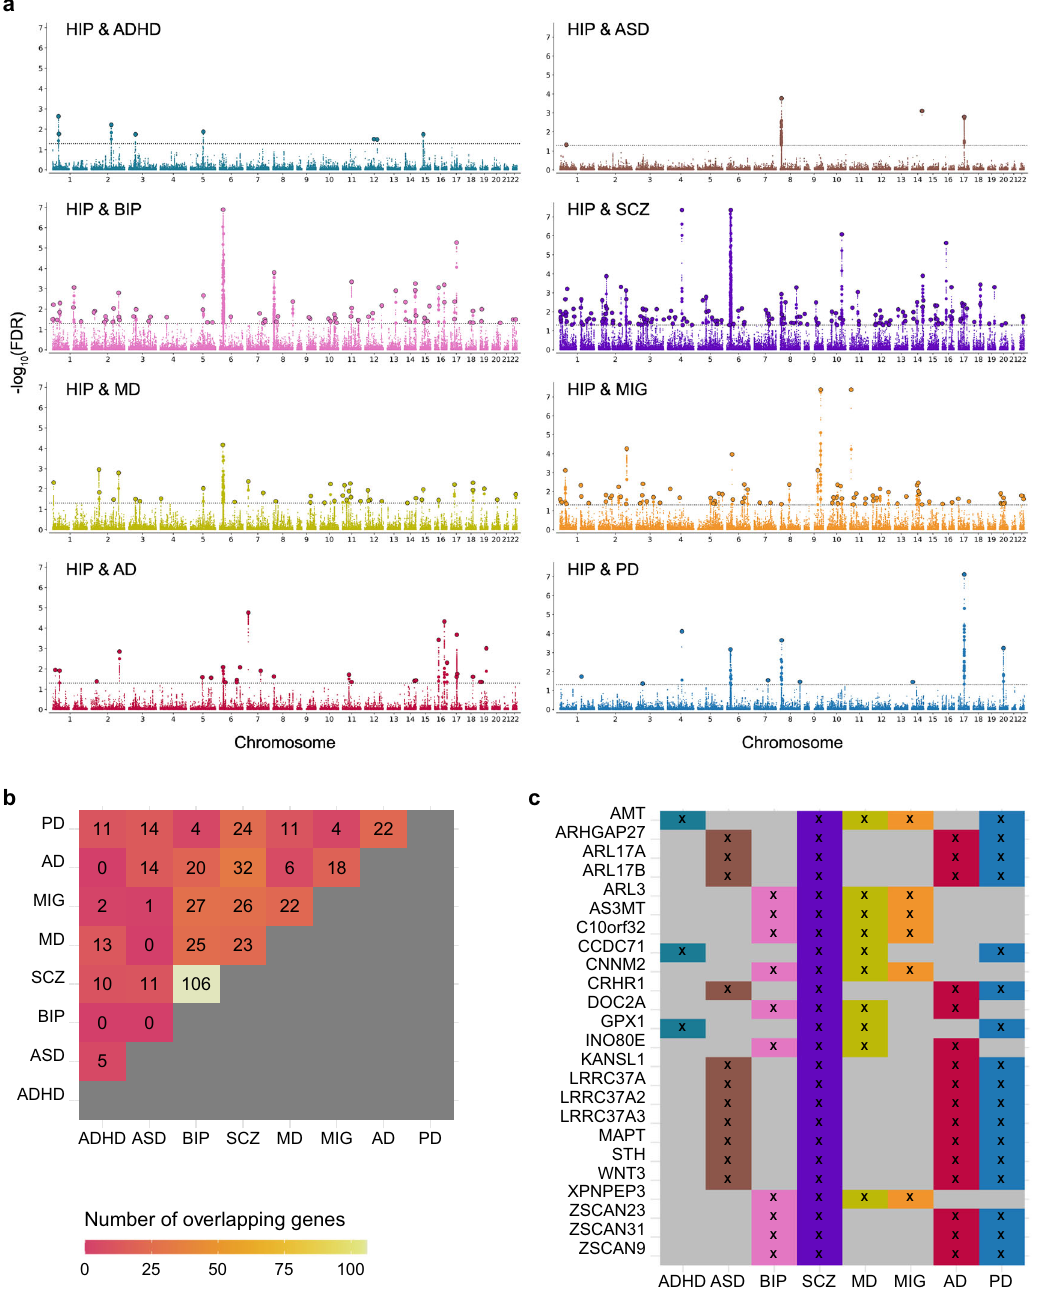
Fig. 3 Genetic overlap between hippocampal formation and eight disorders with different onset times across the lifespan. a For each disorder, a conjunctional FDR Manhattan plot is shown, illustrating the – log10 transformed conjunctional FDR values for each SNP on the y- axis and chromosomal positions along the x -axis. The dotted horizontal line represents the threshold for signi fi cant shared associations (conjFDR < 0.05). Independent lead SNPs are encircled in black. b Various genes mapped from the conjunctional FDR analysis were implied to overlap between hippocampal formation and multiple disorders. The fi gure illustrates the total number of genes implied in each combination of disorders. For example, 106 of the genes overlapping between hippocampal formation and SCZ were also found to overlap between hippocampal formation and BIP. c Panel c complements panel b with a list of genes that were implied for more than 3 disorders. One gene was mapped for fi ve disorders ( AMT ) and 23 genes were mapped for four disorders. ASD autism spectrum disorder, ADHD attention de fi cit hyperactivity disorder, SCZ schizophrenia, BIP bipolar disorder, MIG migraine, MD, major depression, PD Parkinson ’ s disease, AD Alzheimer ’ s disease and HIP hippocampal identi fi ed in previous work, implicating a distributed nature of implied for disorders with onset in different phases of life suggests effects on hippocampus. The mapped genes have roles in neu- age-independent neuropathology and may pinpoint potential robiological processes across the lifespan. Importantly, the pro- disease-independent drug targets. found overlap between hippocampal formation and common The distributed genetic architecture across the hippocampal brain disorders and the identi fi cation of some of the same genes formation, here revealed through 177 hippocampus-associated